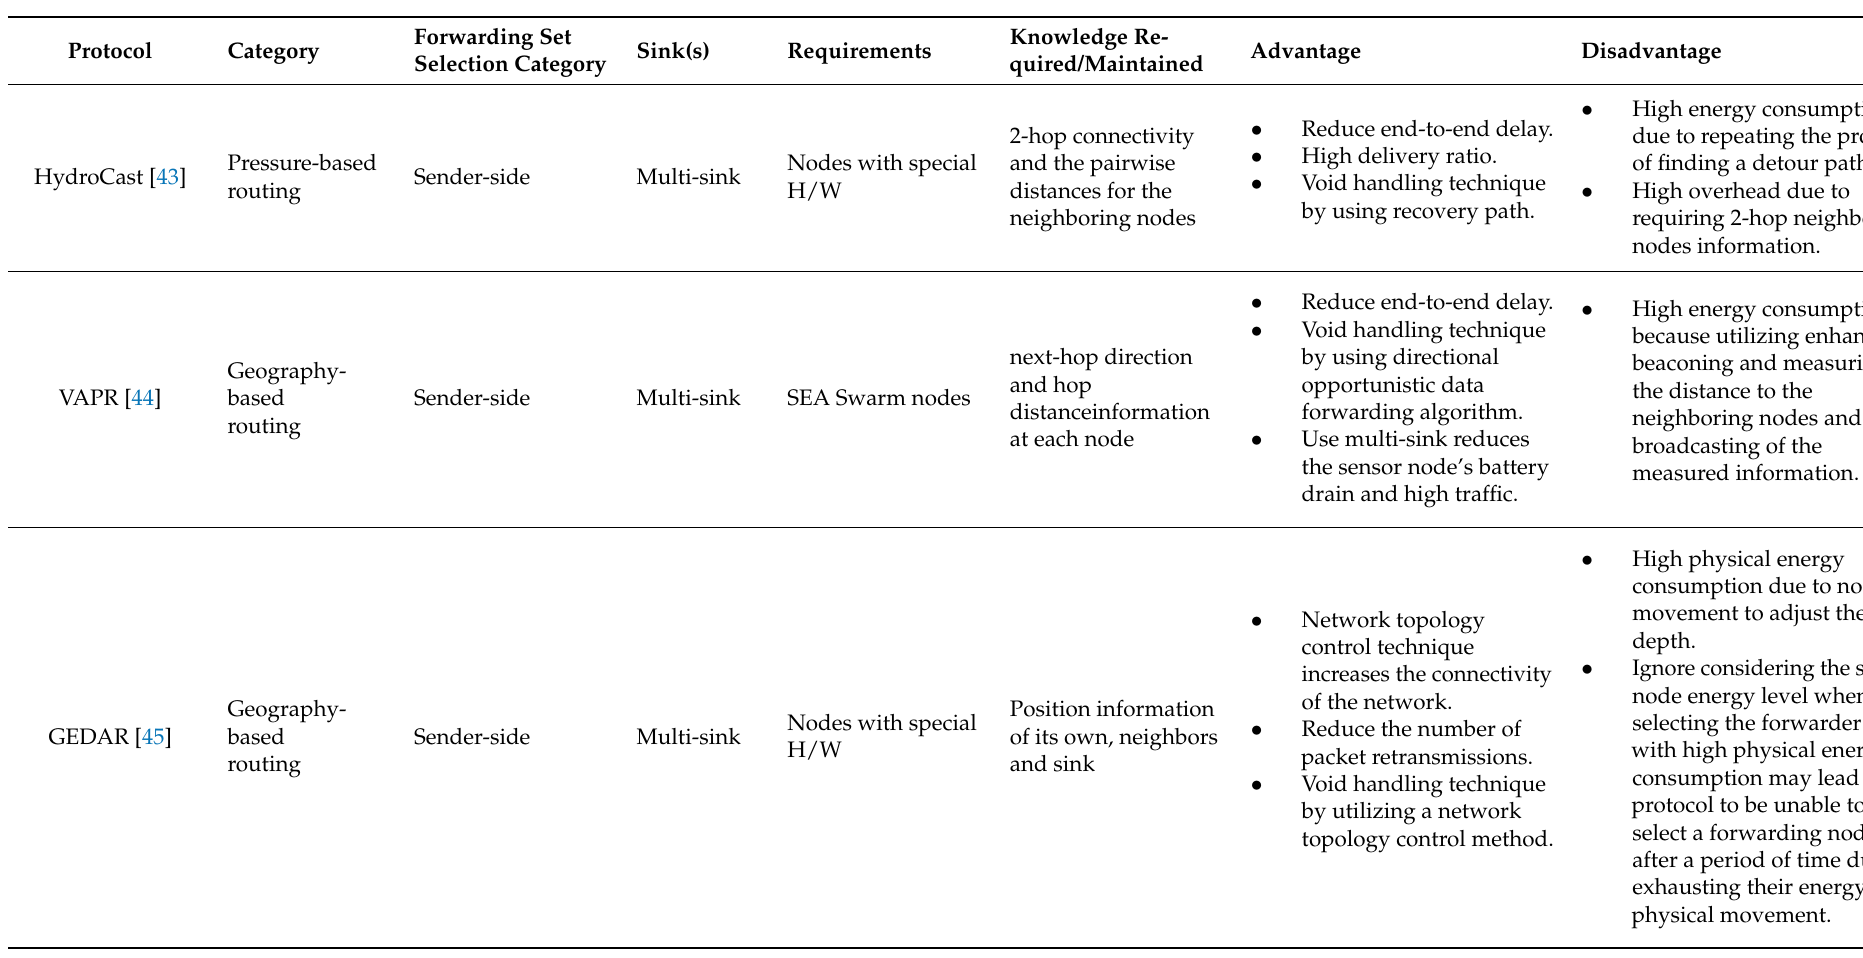
Table 1. Comparison between void avoiding OR